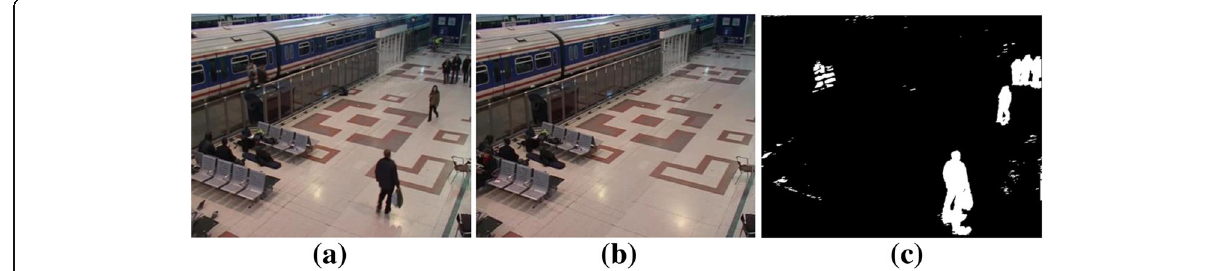
Fig. 2 Moving object detection results. a Original image. b Background. c Segment